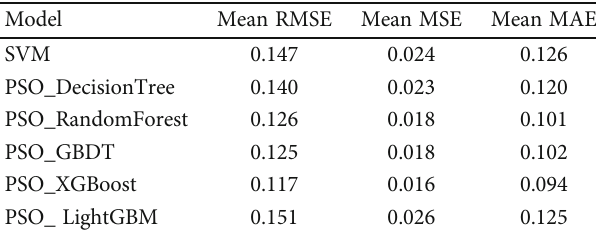
Table 3: Prediction error comparison between experiment